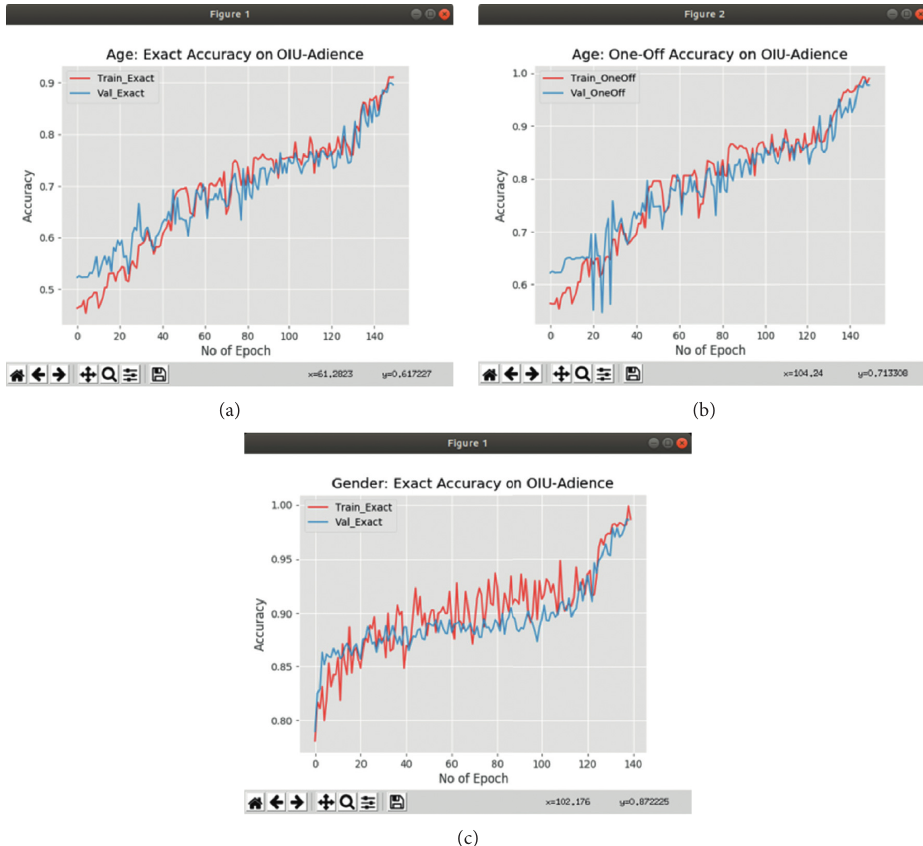
Figure 5: Graphs of accuracy results for the age group and gender classification. (a) Exact accuracy for age classifier. (b) One-off accuracy for age classifier. (c) Exact accuracy for gender classifier. Table 4: Age group classification: performance comparison of our result with the state-of-the-art works on OIU-Adience dataset. Methods